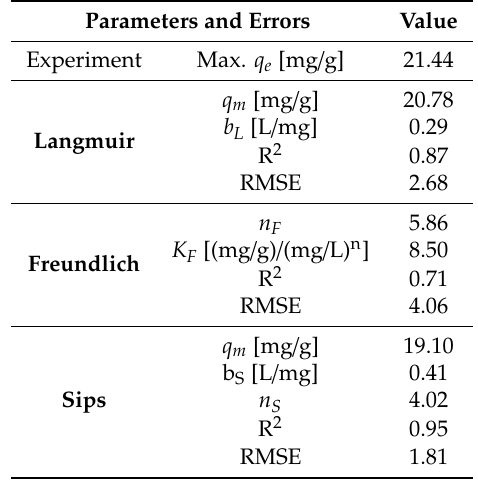
Table 3. Isotherm parameters of Langmuir, Freundlich, and Sips